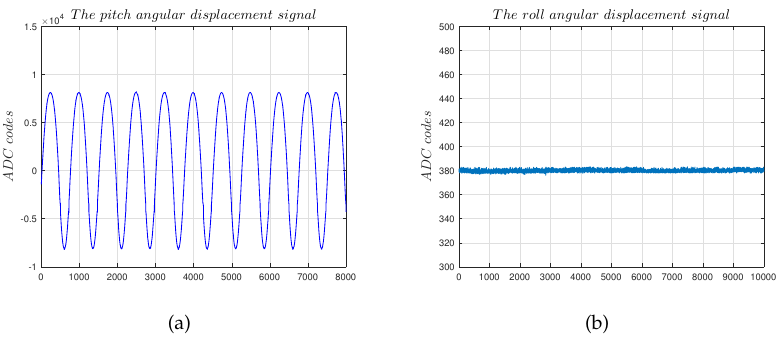
Figure 18. Single-axis measurement experiments: ( a ) solution results of the angular displacement signal α 1 ; ( b ) solution results of the angular displacement signal α 2